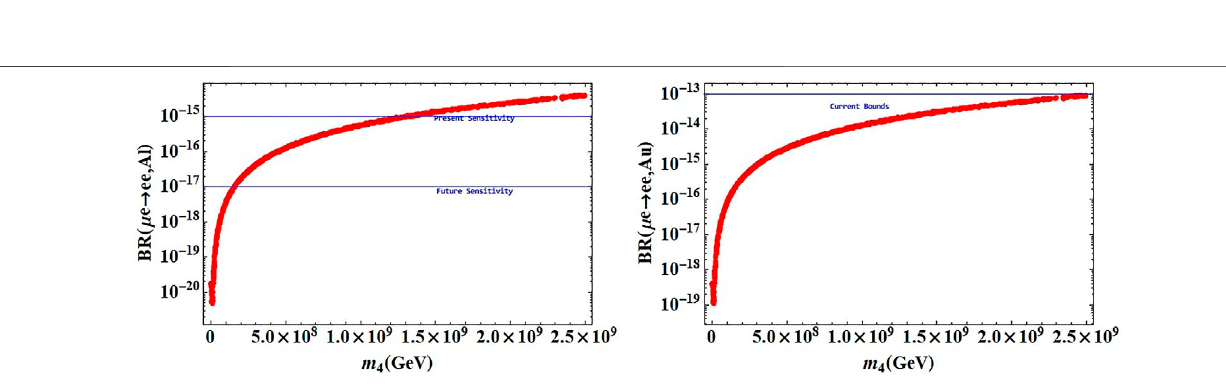
Frontiers in Physics |